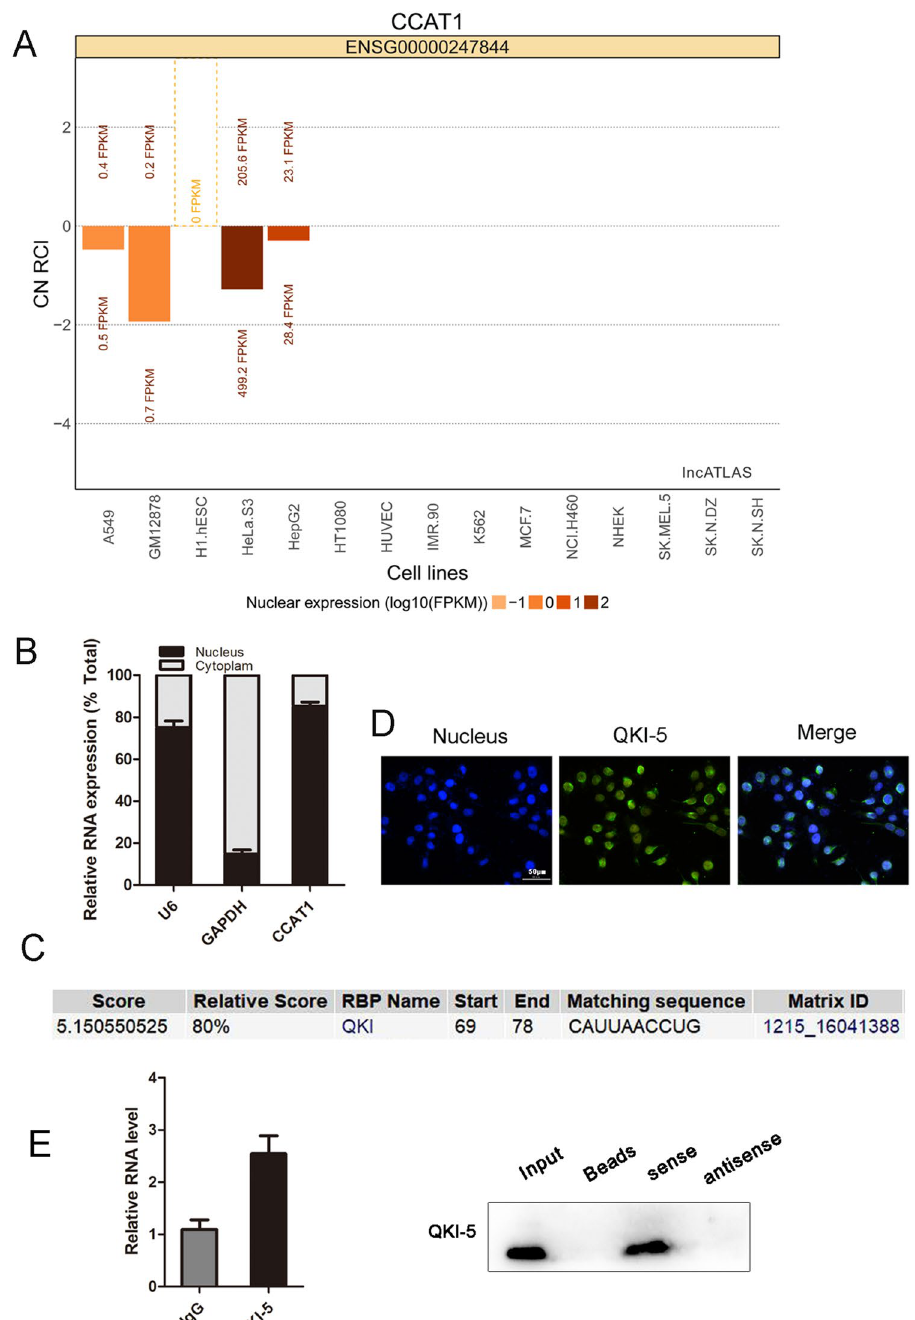
Figure 3. CCAT1 interacted with QKI-5. ( A ) Subcellular localization plots displayed by lncATLAS. ( B ) This nuclear location was confirmed by the cytoplasmic and nuclear extracts measured from qRT- PCR. ( C ) RNA-binding proteins of CCAT1 was predicted by RBPDB (http:// rbpdb. ccbr. utoro nto. ca/) database. ( D ) Immunohistochemistry staining indicated that QKI-5 was located in the nucleus (Original magnification: × 400). ( E ) CCAT1 was enriched with QKI-5-immunoprecipitation. RNA pull-down assay was applied to detect the QKI-5